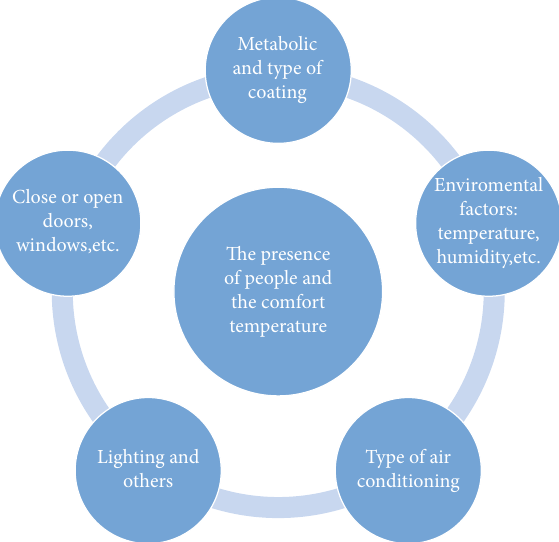
Figure 11: In fl uence of di ff erent behavioral characteristics of cooling energy consumption from the presence of people and comfort